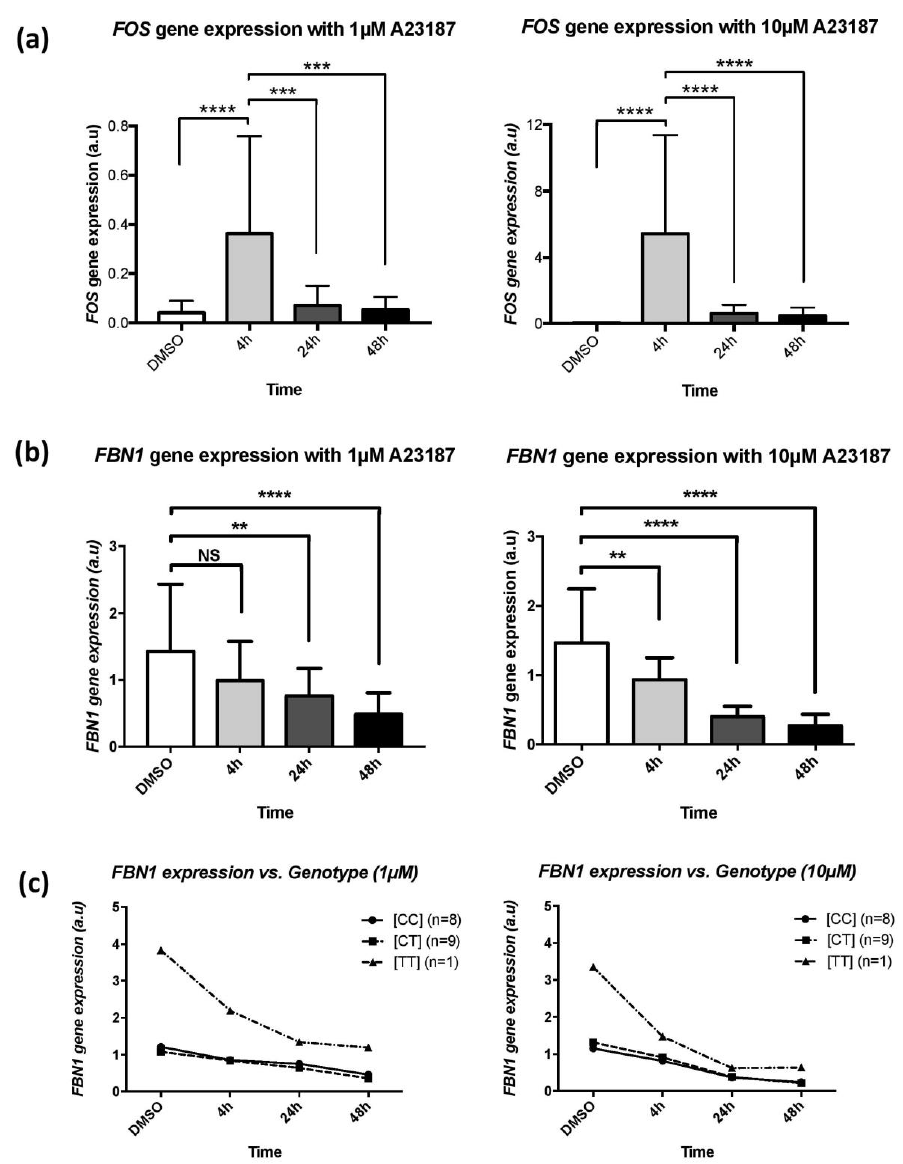
Figure 3. Effect of A23187 on gene expression. Patients’ skin fibroblasts were incubated with DMSO (untreated), 1 µ M or 10 µ M of A23187 for 4 h, 24 h, and 48 h. ( a ) FOS gene expression. ( b ) FBN1 gene expression after treatment with A23187 (Control vs. 4 h: p -value = 0.0082; Control vs. 24 h: p -value < 0.0001; Control vs. 48 h: p -value < 0.0001). ( c ) FBN1 gene expression according to rs11212346 genotype (Control vs. 4 h: p -value = 0.0906; Control vs. 24 h: p -value = 0.0075; Control vs. 48 h: p -value < 0.0001). Genotype: [CC] (n= number of subject); [CT] (n); [TT] (n). [NS] p -value > 0.05; ** p -value < 0.01; *** p -value < 0.001; **** p -value <